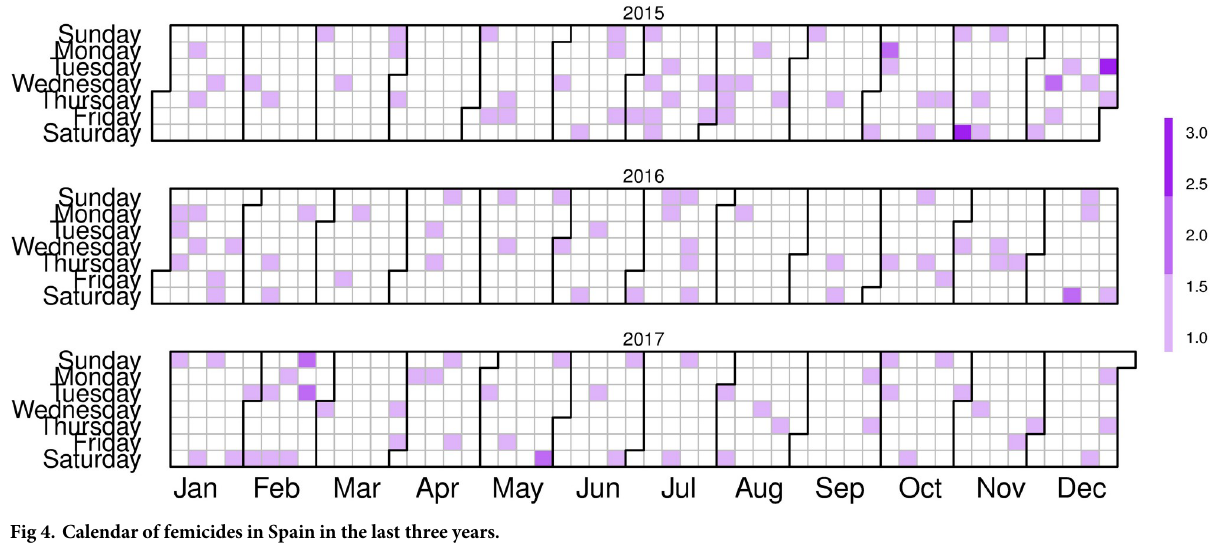
Fig 4. Calendar of femicides in Spain in the last three years.